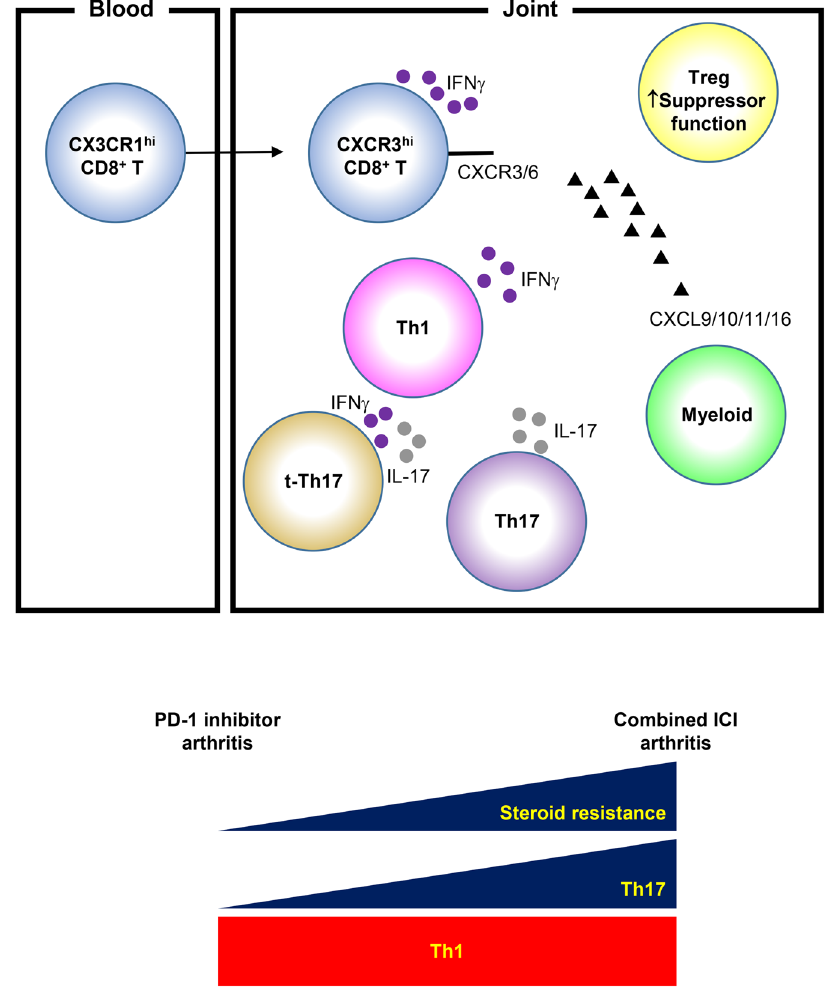
Fig. 7 Graphical abstract of the study. ICI immune checkpoint inhibitors; IFN γ interferon